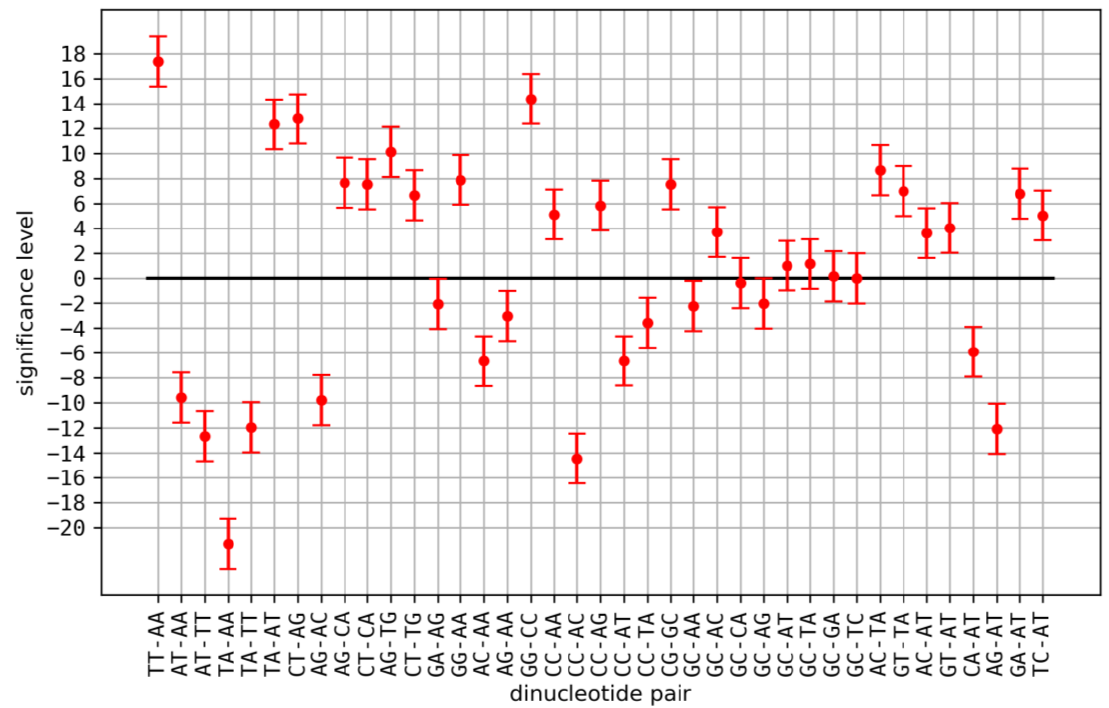
Figure 2. Significance levels of dimer pairs: a representative selection (see Figure S1 for all dinucleotides) of significance levels for correlations (see Section 2.1) of different dinucleotide pairs (x-axis) in relation to the Chargaff model. Deviations from zero larger than 1.0 were not expected by the model and are thus considered significant.